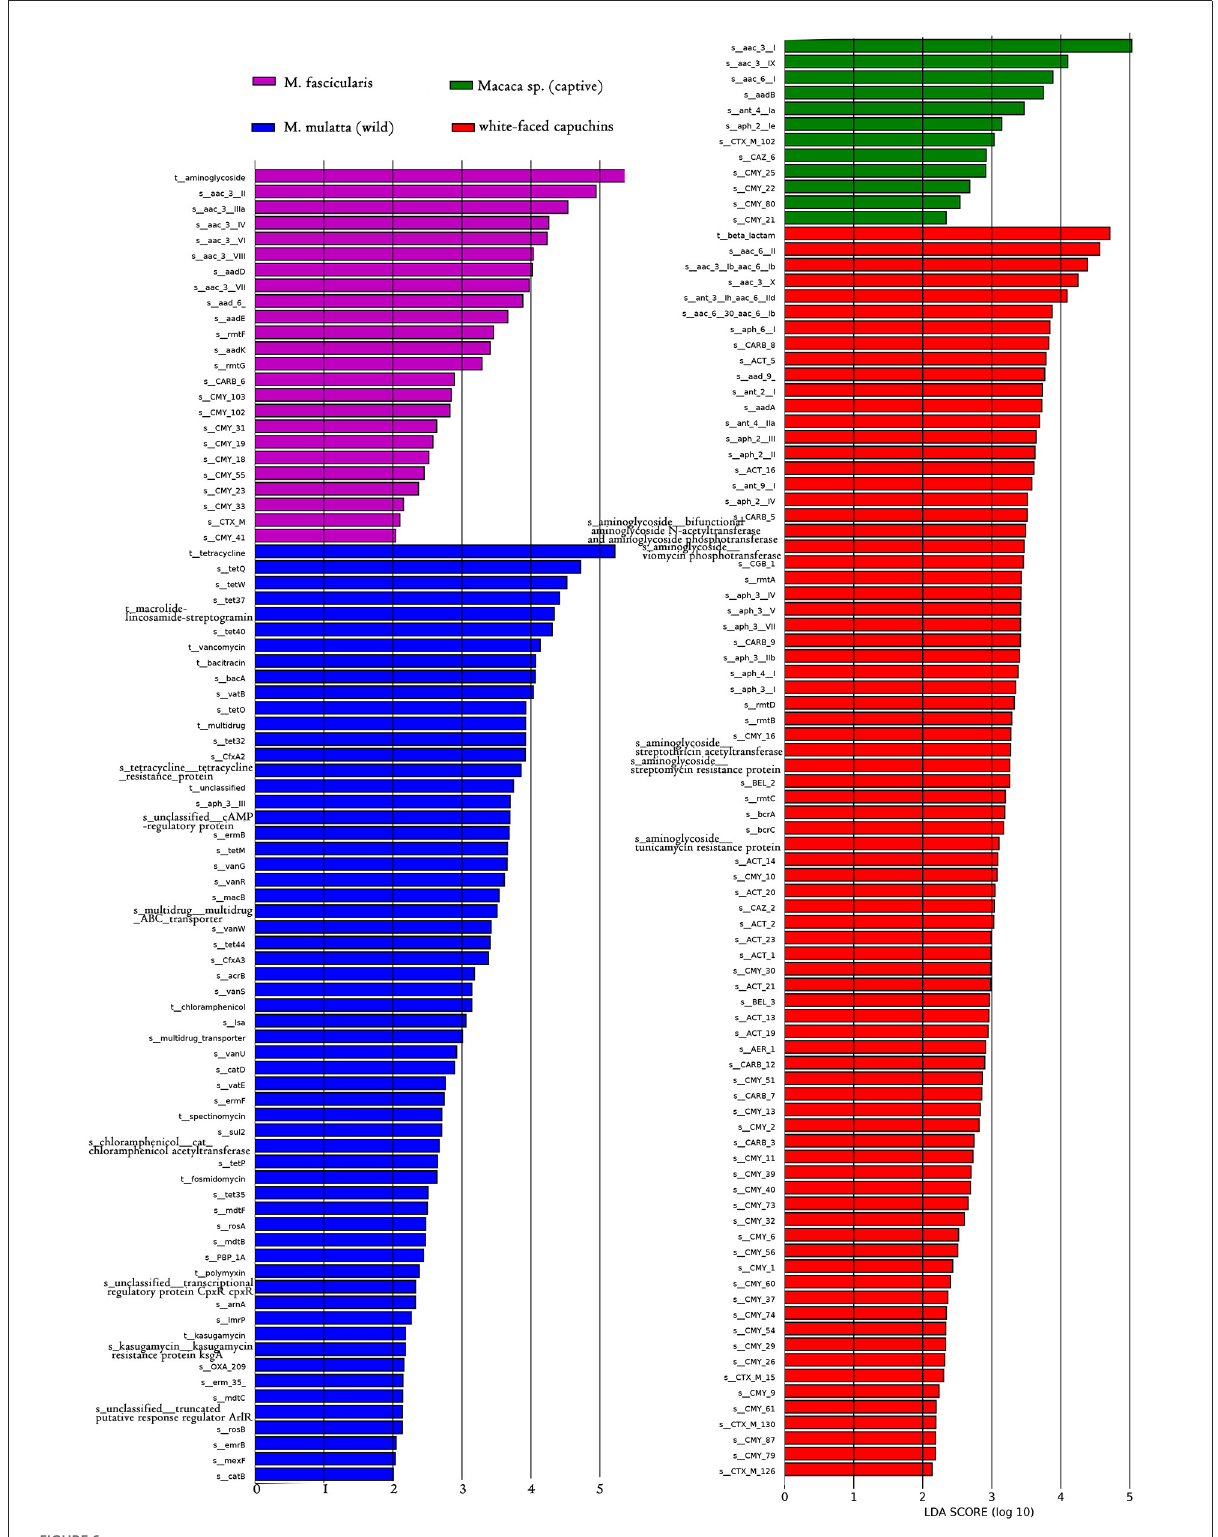
FIGURE6 LDA score distribution of the discriminative ARGs between white-faced capuchins, Macaca sp. (captive), M. mulatta (wild) and M. fascicularis fecal microbiomes determined by LEfSe analysis. The red rectangle, green rectangle, blue rectangle, purple rectangle represent white-faced capuchins, Macaca sp. (captive), M. fascicularis samples, and M. mulatta (wild), respectively, of which ARGs’ LDA score are more than